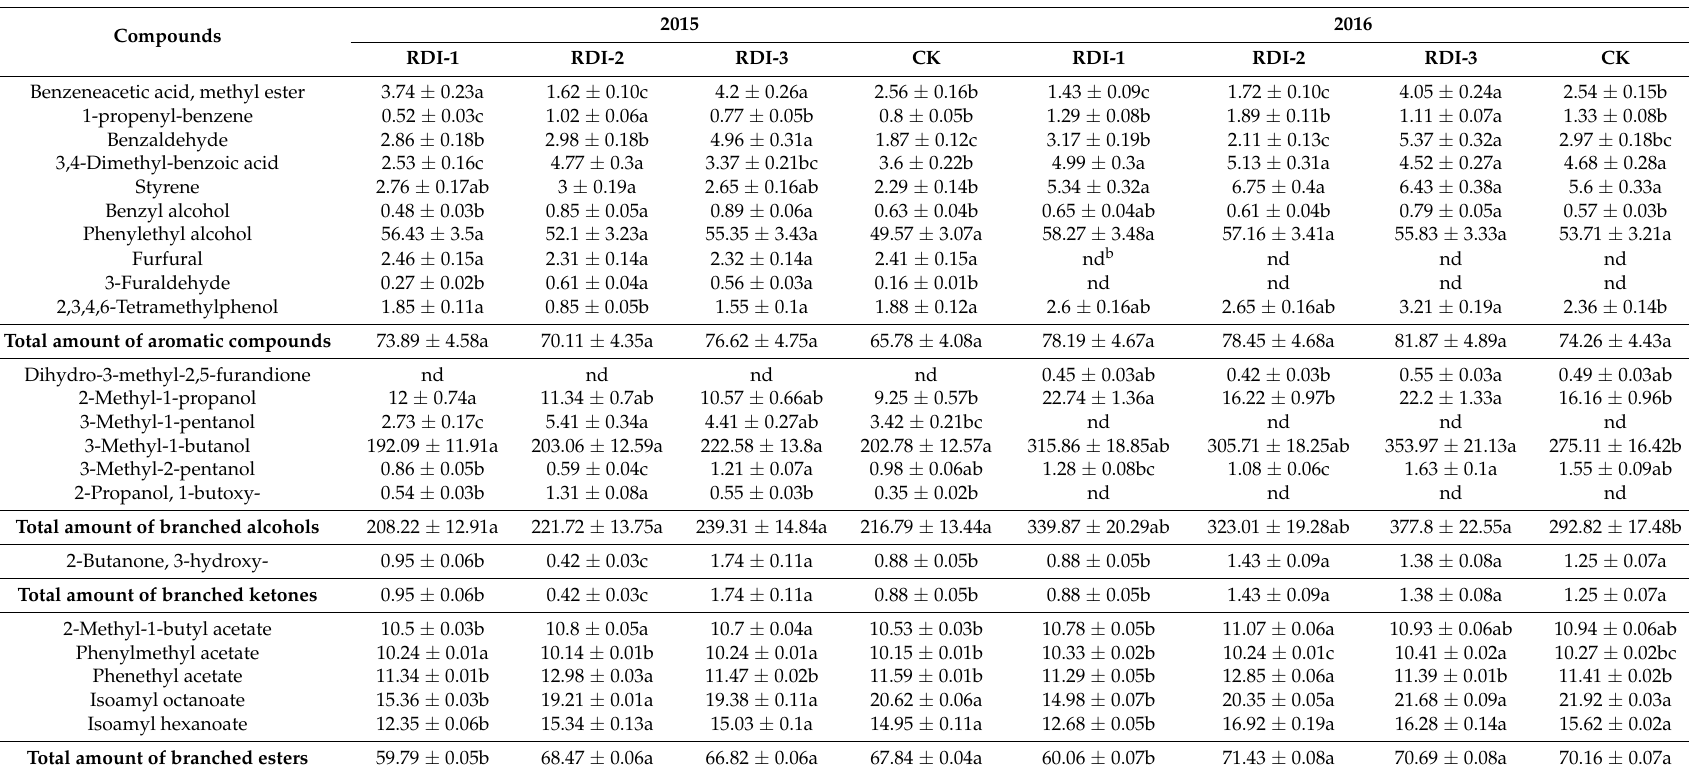
Table 4. Volatile compound concentrations ( µ g/L) in wines from untreated (CK) and treated